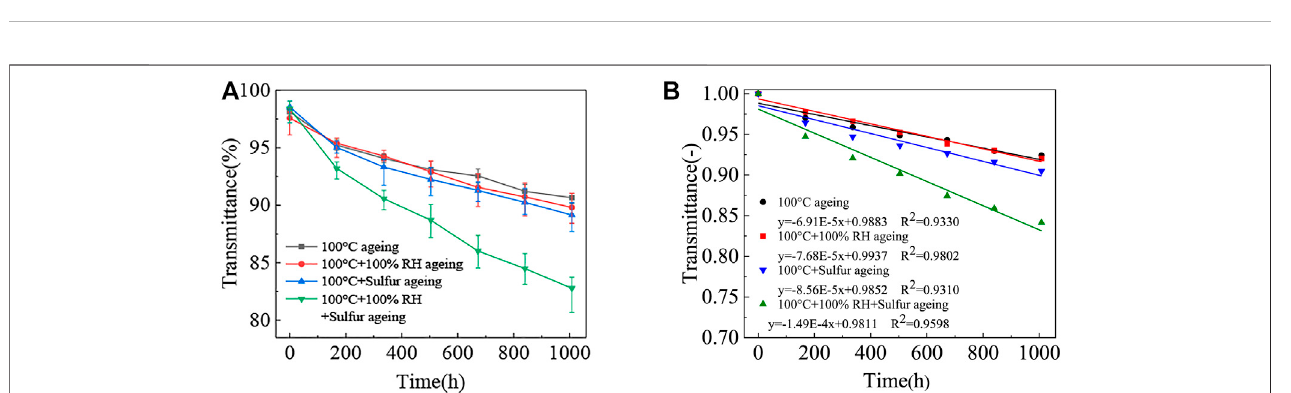
FIGURE 4 | (A) Light transmittance of four groups of samples vs. ageing time; and (B) their linear fi tting results.